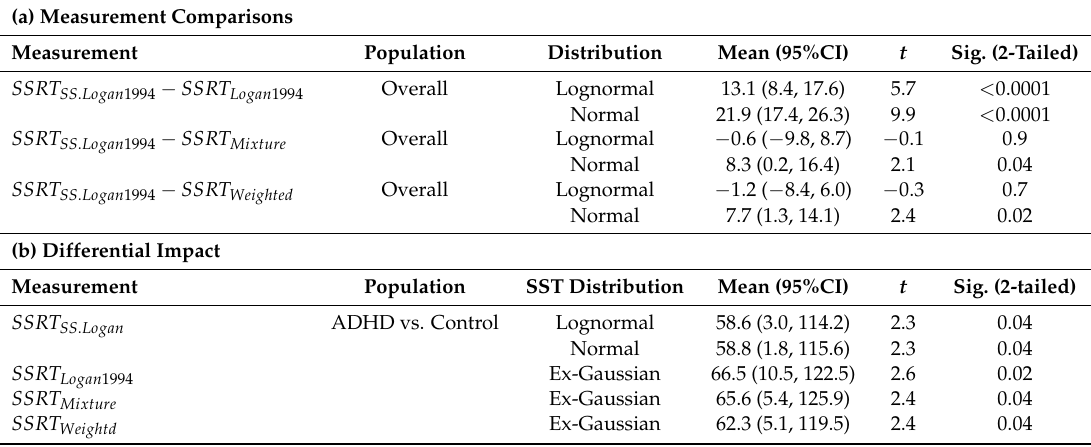
Table 4. Paired t -test and two sample t -test results of SSRT indices by distributional assumption (n =